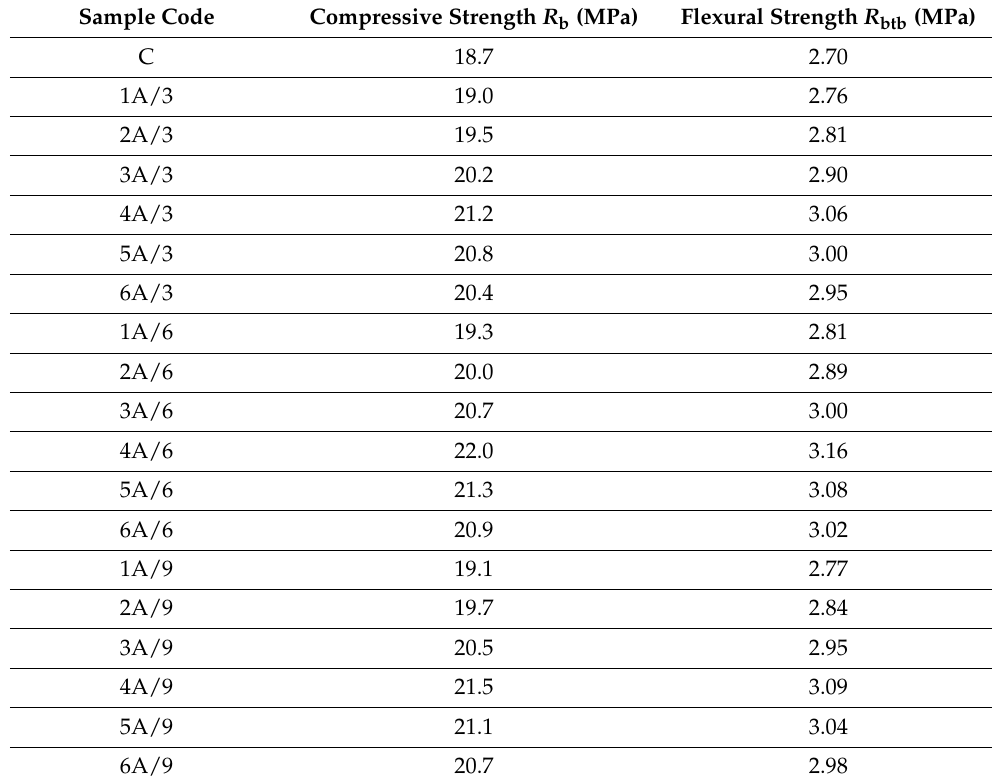
Table 7. Results of determining the strength characteristics of geopolymer